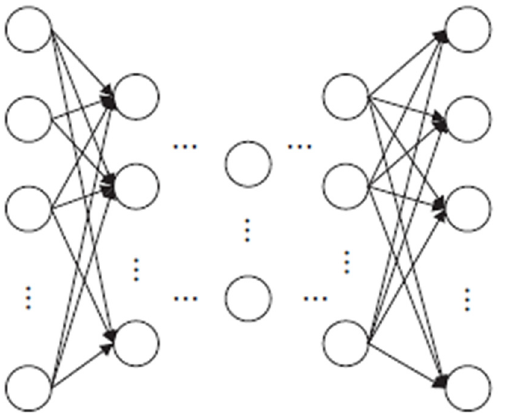
Figure 2. The structure of a DAE.